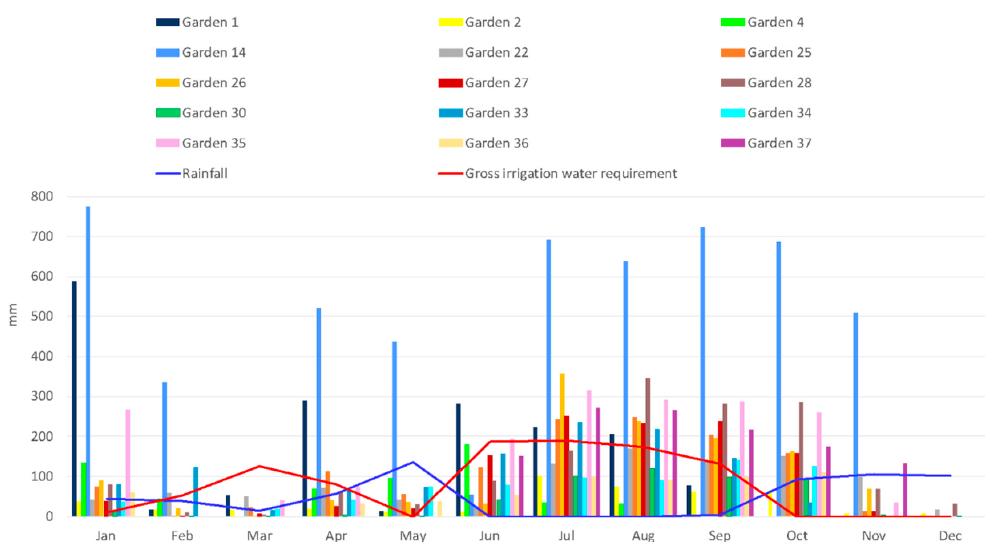
Figure 4. Rainfall, evapotranspiration and gross irrigation water Requirements (GIWR) of the urban green areas from São Brás de Alportel in 2016.